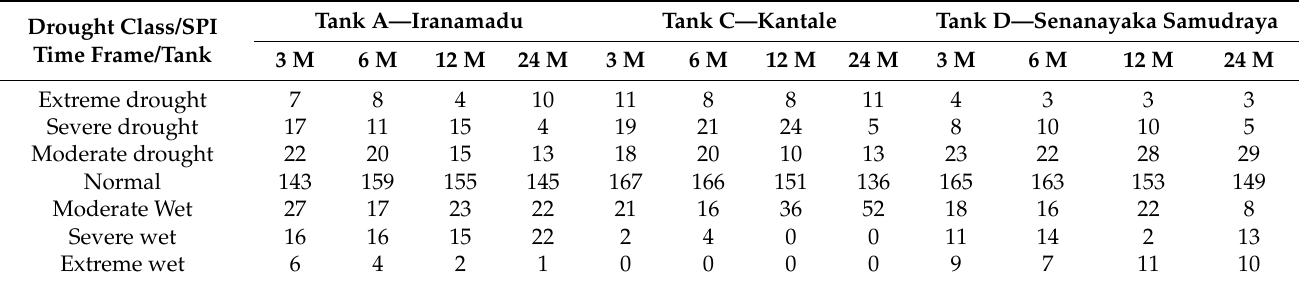
Table 6. Number of months for different drought classes from 2001 to 2020 at different reservoir